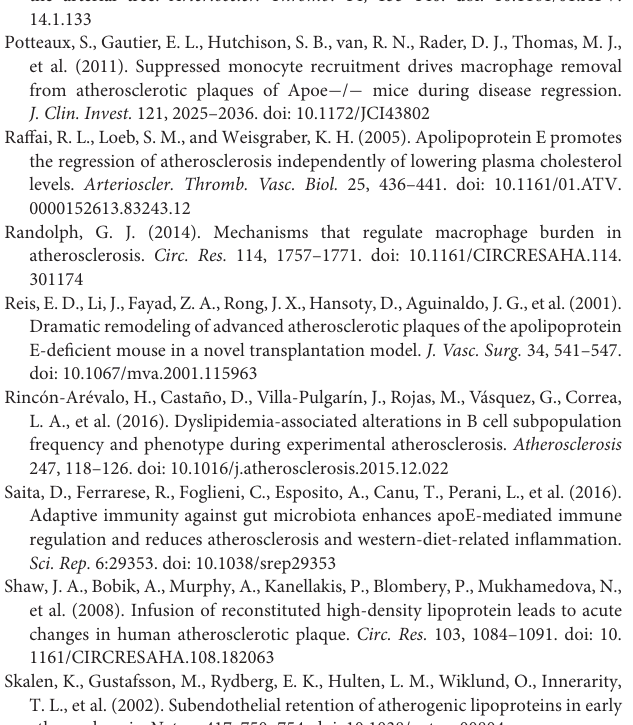
Tabas, I. (2010). Macrophage death and defective inflammation resolution in atherosclerosis. Nat. Rev. Immunol. 10, 36–46. doi: 10.1038/nri2675 Tabas, I., and Bornfeldt, K. E. (2016). Macrophage phenotype and function in different stages of atherosclerosis. Circ. Res. 118, 653–667. doi: